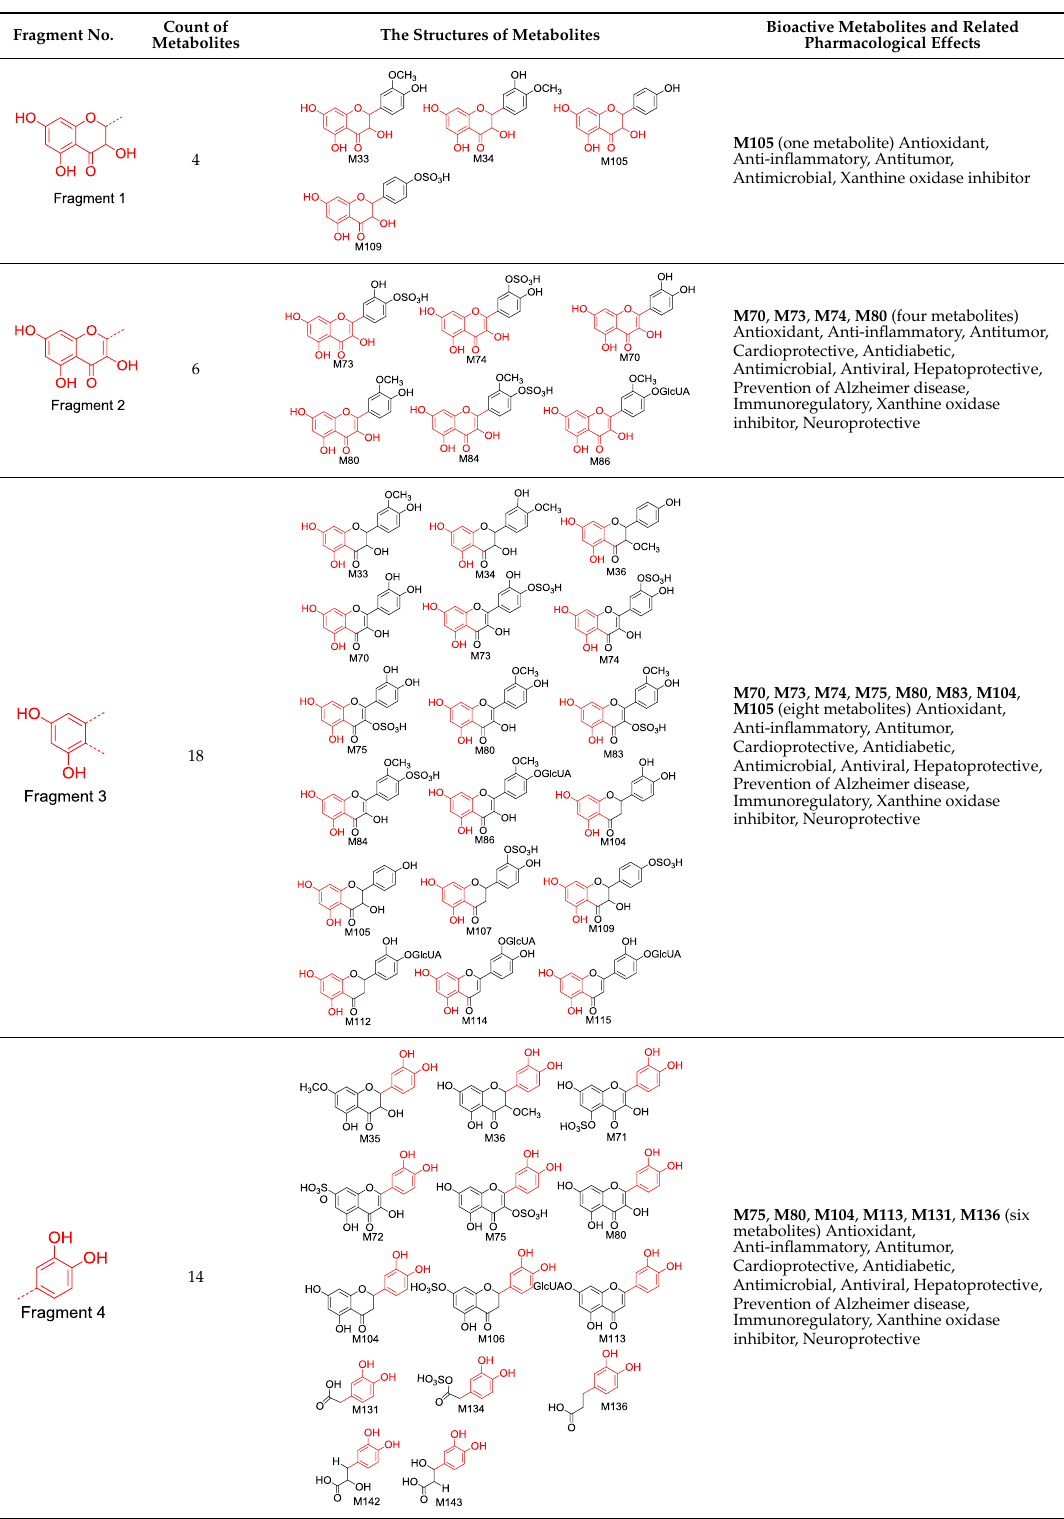
Table 4. The common fragments (in red) and their related metabolites.